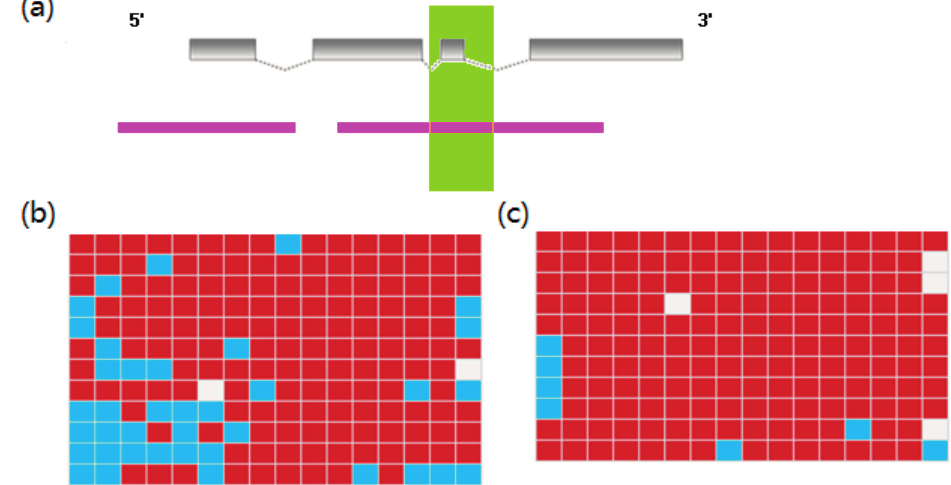
Figure 6. DNA methylation profiling of klf4a in red skin and white skin. ( a ) The genome structure and predicted CpG Islands of klf4a . The grey boxes symbolized exons of klf4a and the spotted fold lines represented introns. The predicted CpG Islands were colored with pink. The selected CpG Island for downstream BS-PCR analysis was shown in the green region; ( b ) DNA methylation status of klf4a in red skin examined with BS-PCR analysis. Each row was a sequenced clone, and a column represented a CpG site. The red boxes were methylated CpG sites and the blue boxes indicated the un-methylated CpG sites. The un-sequenced CpG sites were shown with the white boxes; ( c ) DNA methylation status of klf4a in white